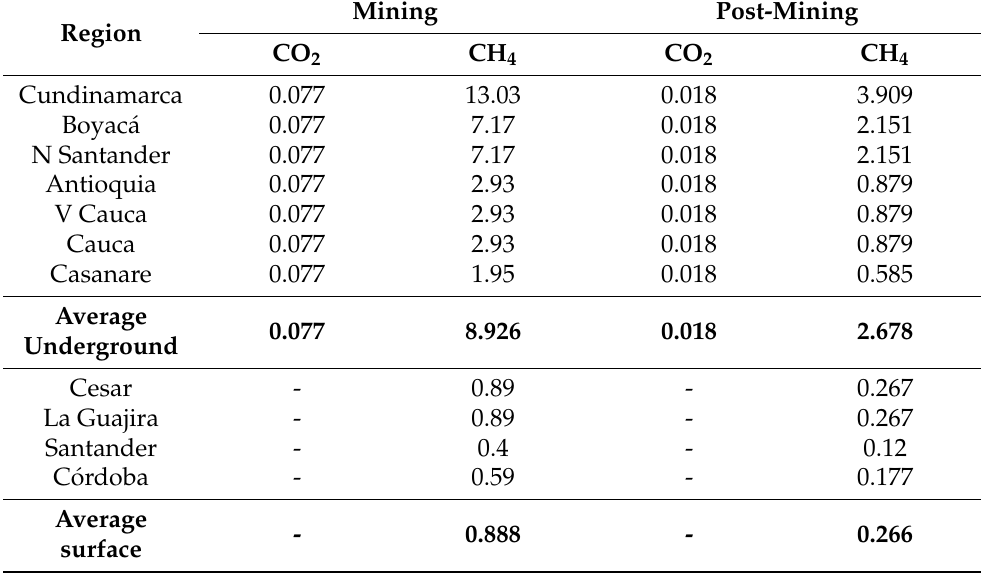
Table A2. Fugitive emission factors for mining in m3/ton.